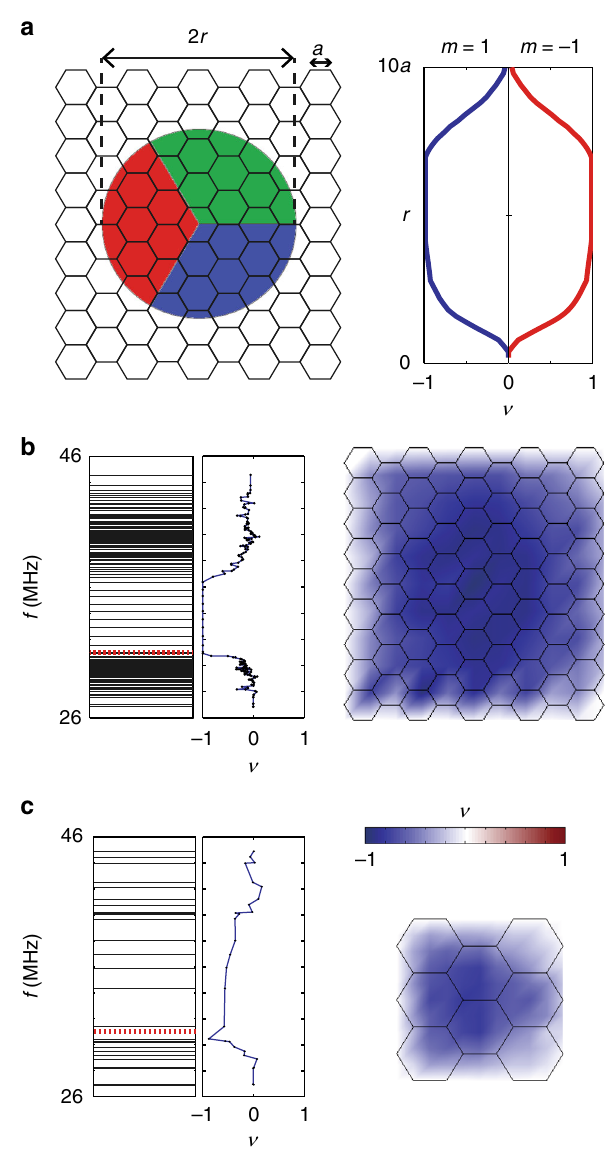
Fig. 3 Local Chern numbers. a We use a circular computational domain for calculating the local Chern numbers at the sample center as a function of the computational domain radius for a 9 × 9 fi nite-size sample. The red, blue and green regions correspond to the A, B and C sectors, respectively. b , c The energy levels (left), local Chern numbers at the sample center (middle) and the local Chern number as a function of position (right) of m = 1 states for 3 × 3 and 9 × 9 samples, respectively, are shown. In the calculations, the radii of their computational domain are set to 2.3 a and 5 a respectively. The black lines represent the eigenfrequencies. The dotted red line in ( b ) in the left panel marks f = 31 MHz, which is set to the cutoff frequency in the local Chern number calculation. The middle panel shows how the local Chern number ν changes with the cutoff frequency, where the center of the computational domain is fi xed at the center of the samples. Each point represents the value of ν by adding up all the eigenstates at and below this